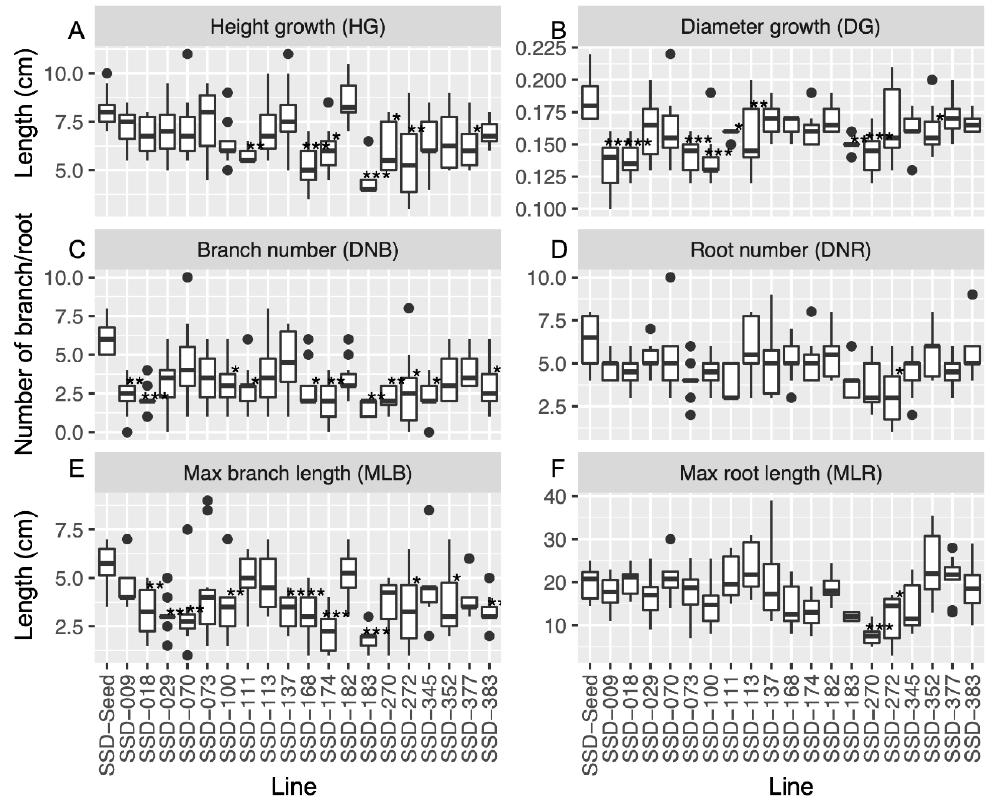
Figure 7. Box plots for the growth traits in somatic plantlets and control seedlings (SSD-Seed) of sugi (Japanese cedar, C. japonica ) for height growth ( A ), diameter growth ( B ), developed number of first-order branches ( C ) and roots ( D ), and maximum length of branches ( E ) and roots ( F ). Significant differences from control seedlings at the 5%, 1%, and 0.1% levels are indicated by *, **, and ***, respectively (Dunnett test). The black dots indicate outliers.